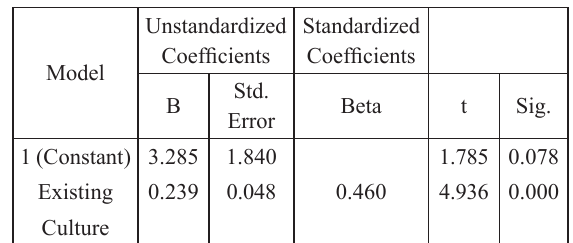
Coefficiency between Existing Culture and Employee Resistance.